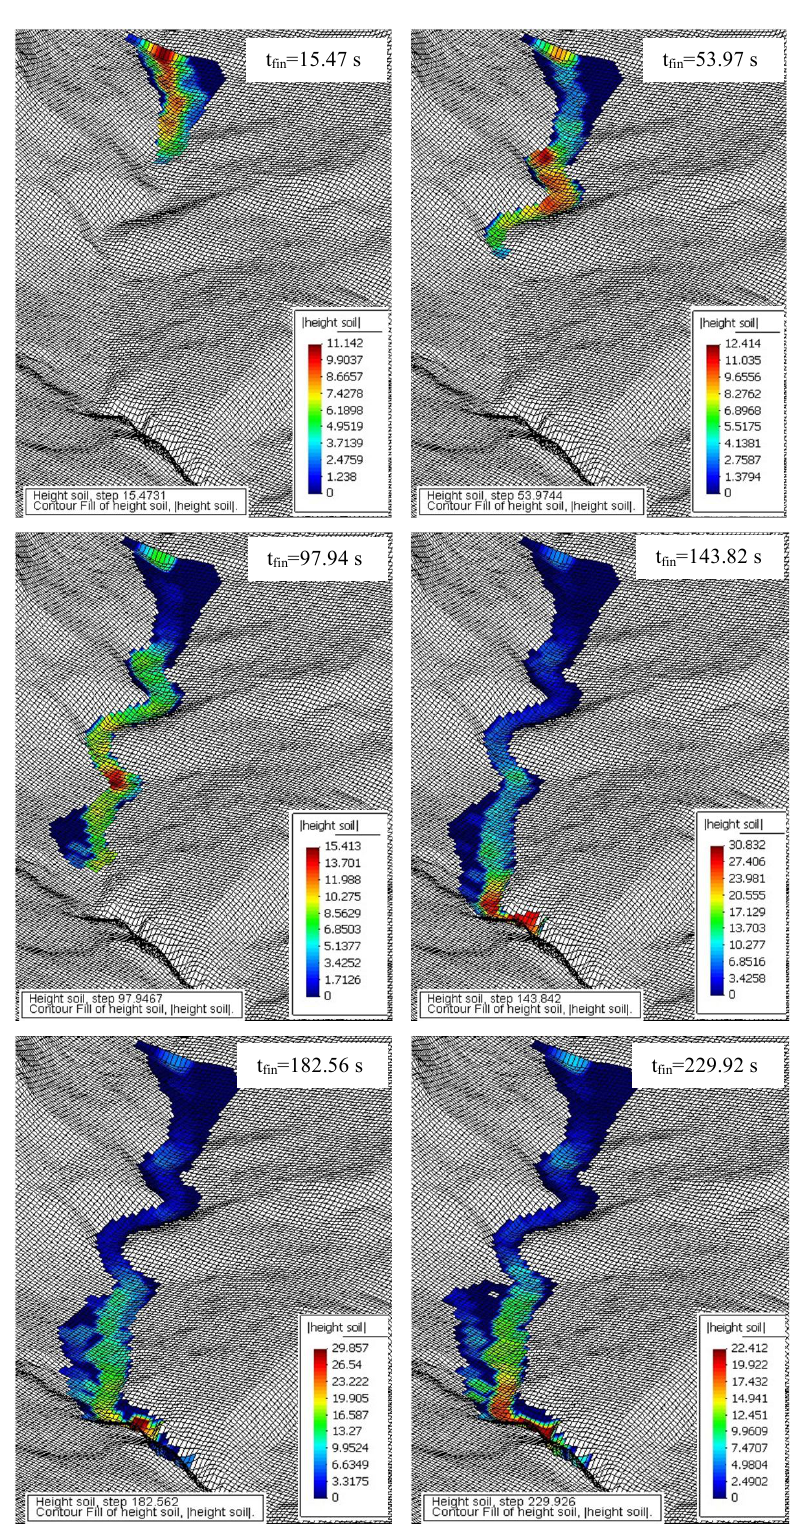
Figure 9. The simulation view of mudflow propagation on the Rjeˇcina River (based on the equidistant mesh grids of 5m × 5m), with the propagation of materials from a natural dam formed on the Grohovo landslide, Simulation